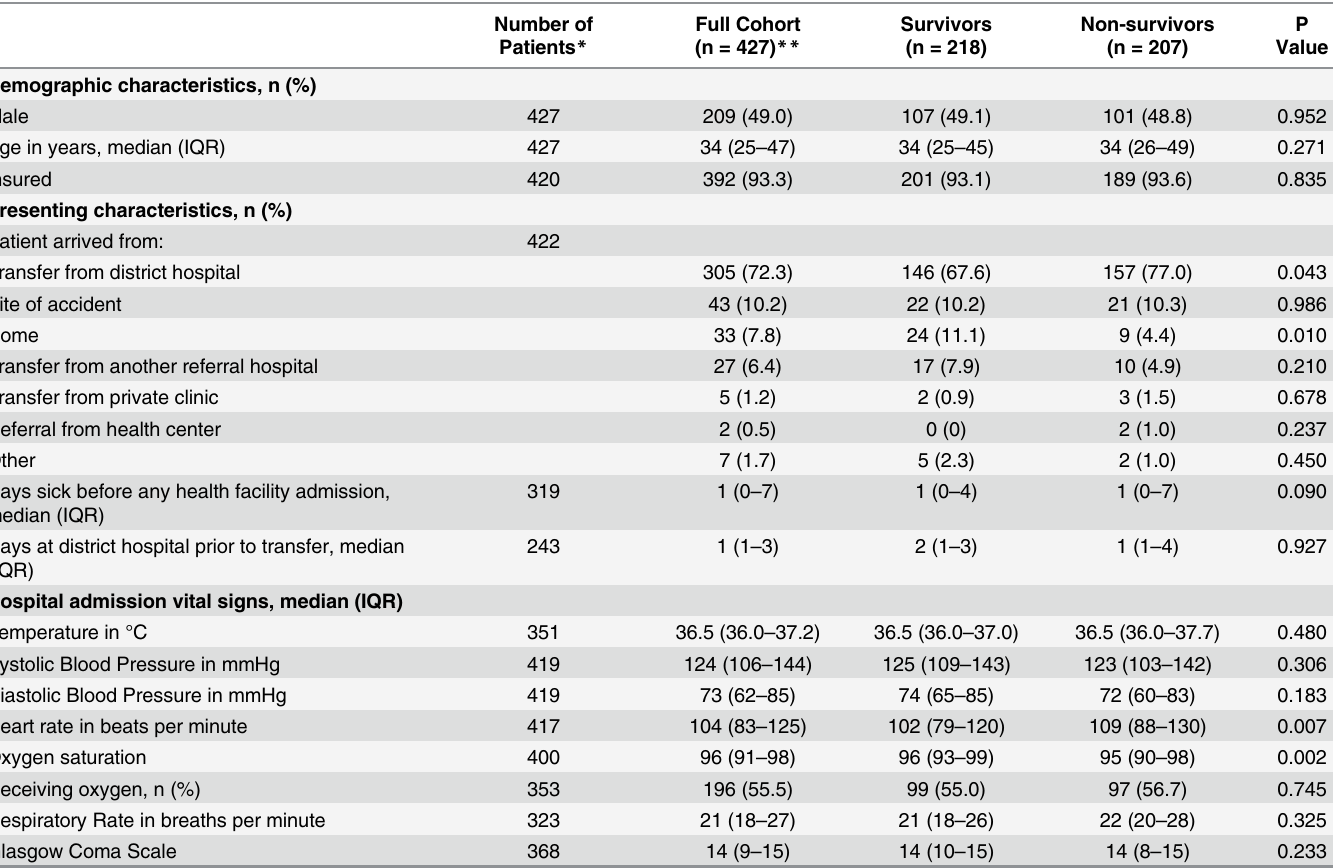
Table 1. Patient characteristics at hospital